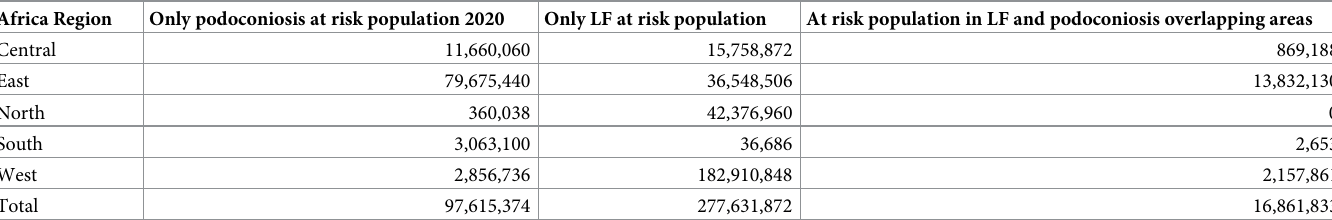
Table 2. Estimates of population living in areas with overlapping risk of podoconiosis and lymphatic filariasis in Africa. Africa